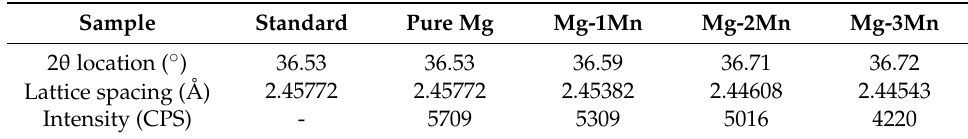
Table 1. The location, lattice spacing, and intensity variation of identified diffraction peak of Mg phase. Sample Standard Pure Mg Mg-1Mn Mg-2Mn Mg-3Mn 2θ location (°) Lattice spacing (Å ) Intensity (CPS) - 5709